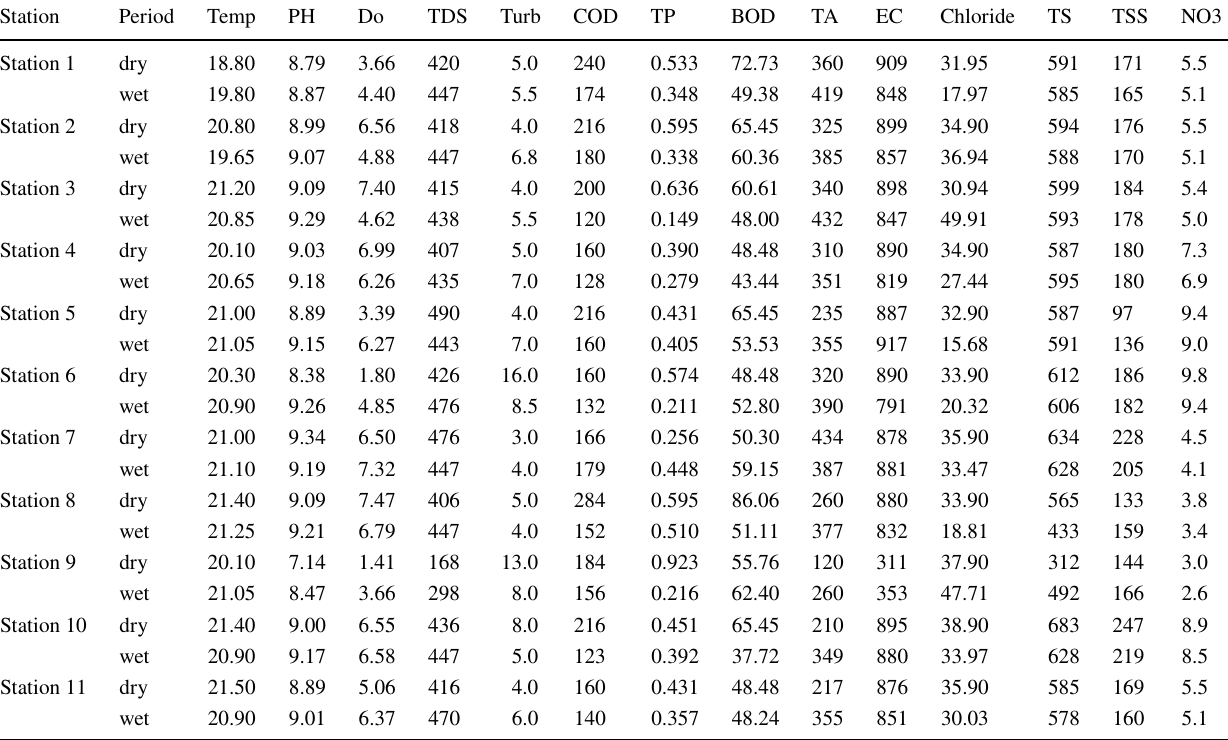
Table 2 Hawassa Lake water quality results in both dry and wet seasons at 11 sampling points Station